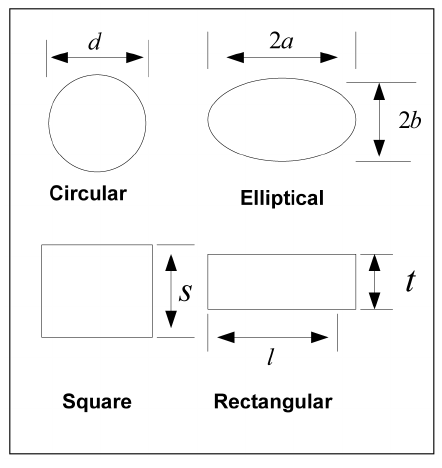
Figure 2. Cross-sections of different geometries.